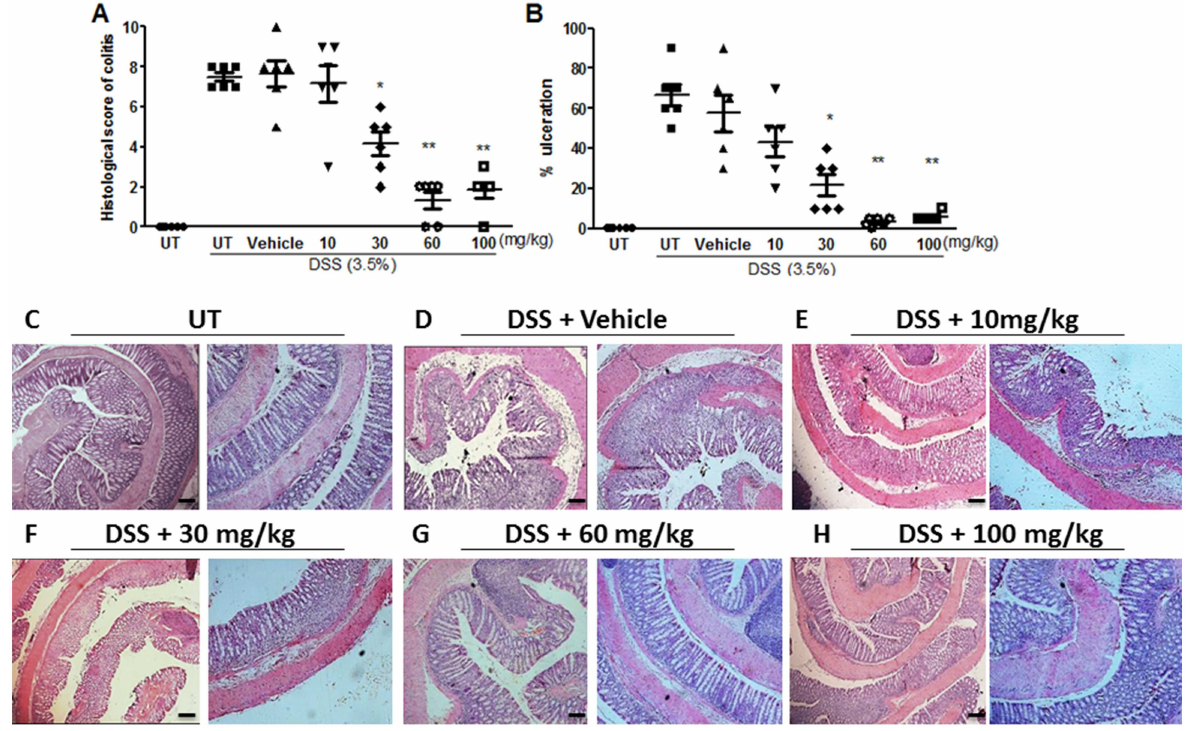
Fig 2. Effect of E121 treatment on the histological score for colitis severity. Panels A and B represent histological assessment of colitis severity and the % of ulcerationin the wholecolon section respectivelyin the groups indicated. Histobars represent means ± SEM for 6 mice in each group. Asterisks denote significantdifference from UT mice with p < 0.05 ( * ) and, p < 0.001( ** ). Panel C illustrates a colon section taken from UT mouse showing normal regularmucosal architecture. Panel D illustrates a colon section taken from mouse treated by daily i.p vehicleplus DSS where there is significantmucosal destructionand immune cell recruitment. Panels E-H illustrate typical colon sections taken from mice treated with various doses of E121 plus DSS. Treatment with 60–100mg/kg doses of E121 improvedmucosal integrity and reducedthe enhanced immune cell recruitment (panels G and H). Bars represent 150 μ m. Left pictures were taken at 5x magnification, whileright pictures were taken at 10x